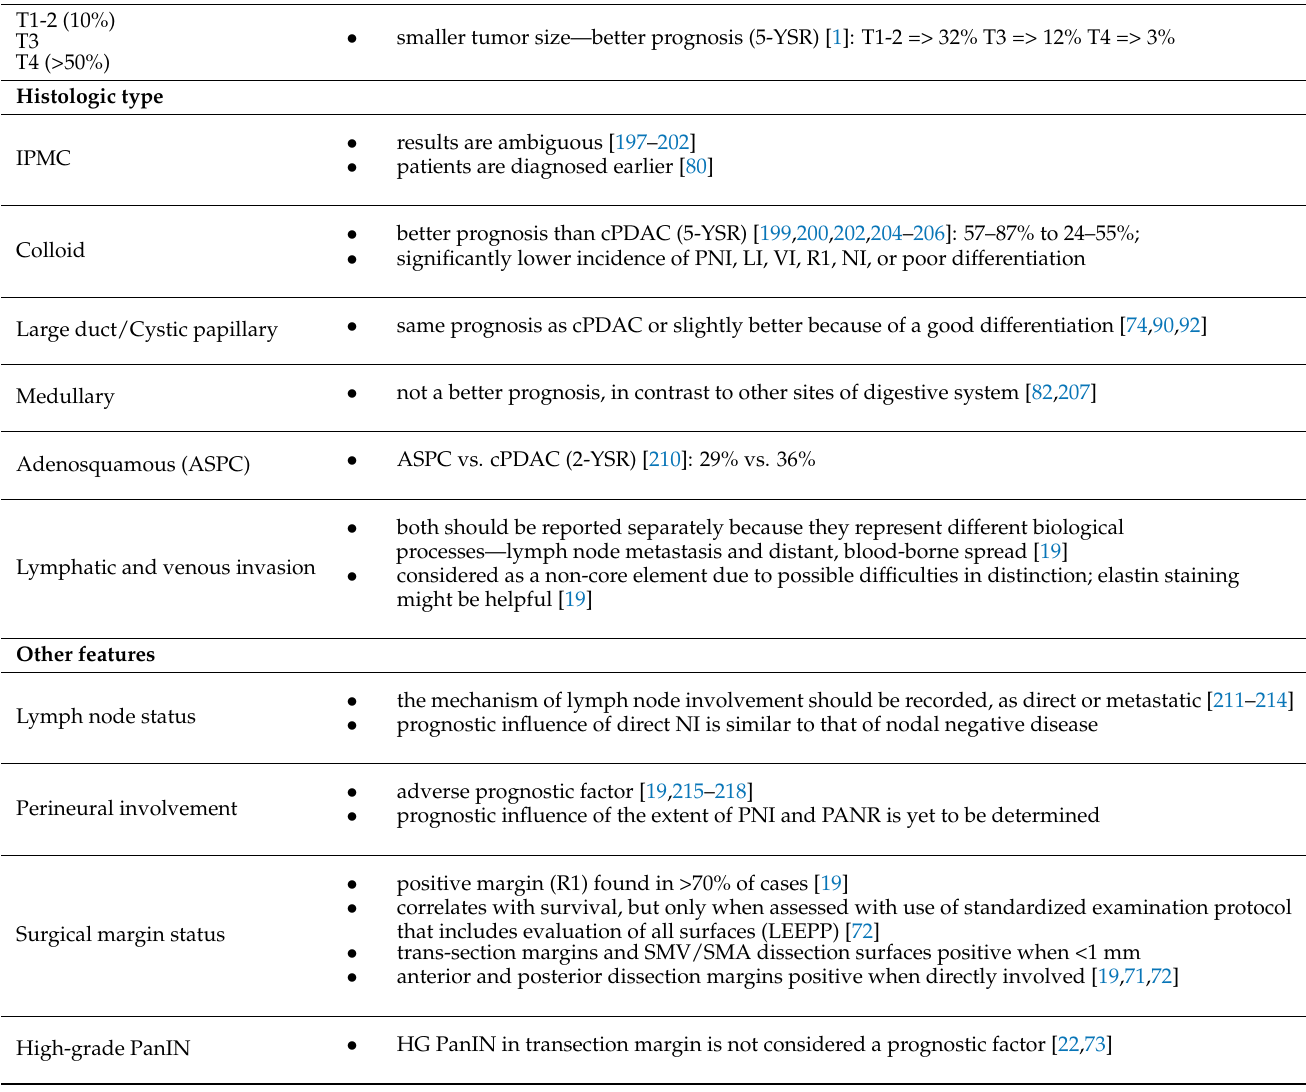
Table 3. Summary of histomorphologic features with prognostic importance. 5-YSR, 5-year survival rate; 2-YSR, 2-year survival rate; cPDAC, conventional pancreatic ductal adenocarcinoma; IPMC, IPMN derived carcinoma; PNI, perineural invasion; LI, lymphovascular invasion; VI, venous invasion; R1, positive surgical margins; NI, nodal involvement; PANR, PDAC-associated neural remodeling; LEEPP, Leeds Pathology Protocol; SMV/SMA, superior mesenteric vein/superior mesenteric artery; HG PanIN, high-grade pancreatic intraepithelial